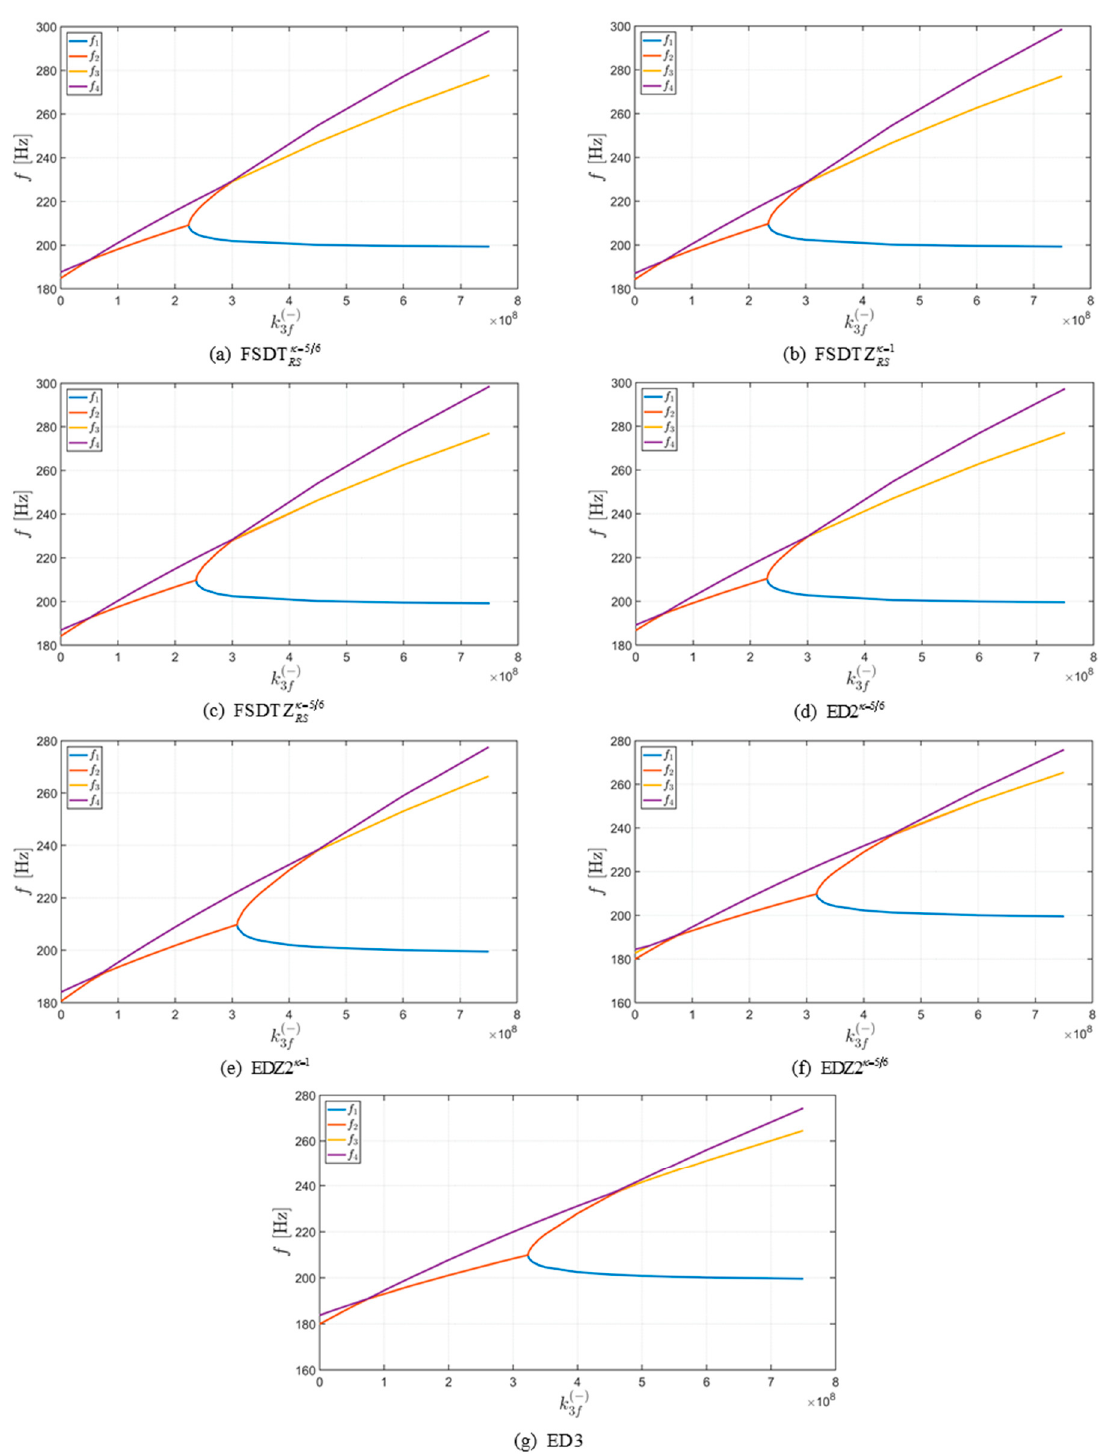
Figure 9. First four frequency modes of a CFCF cylindrical surface (Figure 4b) reinforced by CNTs distributed as in Figure 5b for the different theories: ( a ) FSDT κ = 5/6 ( d ) ED2 κ = 5/6 ; ( e ) EDZ2 κ = 1 ; ( f ) EDZ2 κ = 5/6 ; ( g ) ED3. The mass fraction was w r = 0.25, and the agglomeration parameters µ 1 = 0.5 and µ 2 = 0.75. The Chebyshev-Gauss-Lobatto grid distribution was employed, with I N = I M =